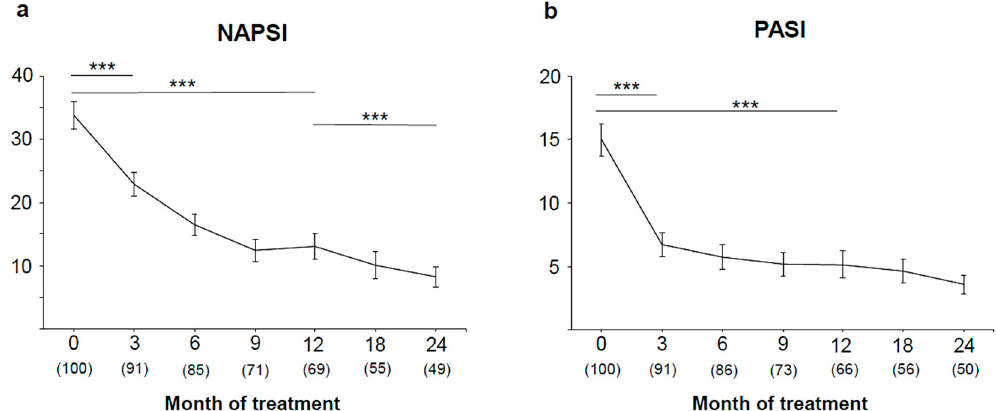
Figure 1. Overall improvement in ( a ) Nail Psoriasis Severity Index (NAPSI) and ( b ) Psoriasis Area and Severity Index (PASI) during therapy. Absolute NAPSI and PASI values (mean ± SEM) and total number of patients per visit are shown. *** p < 0.001.